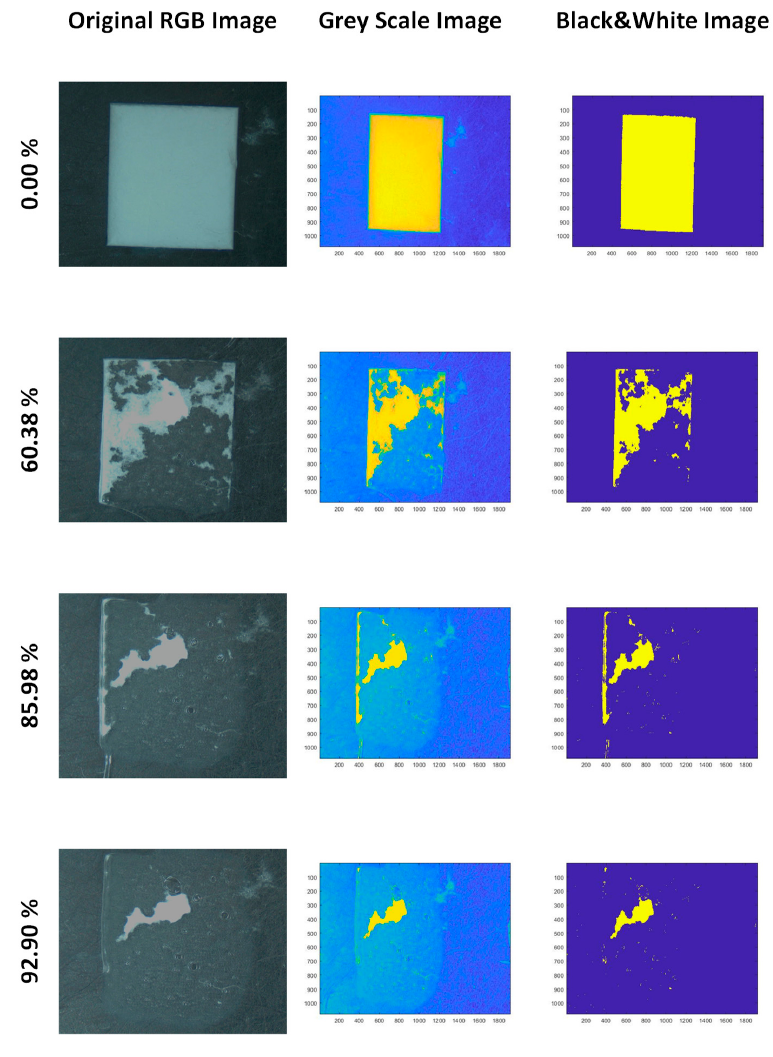
Figure 10. Image analysis to monitor dissolution process of the PEO-based specimens.